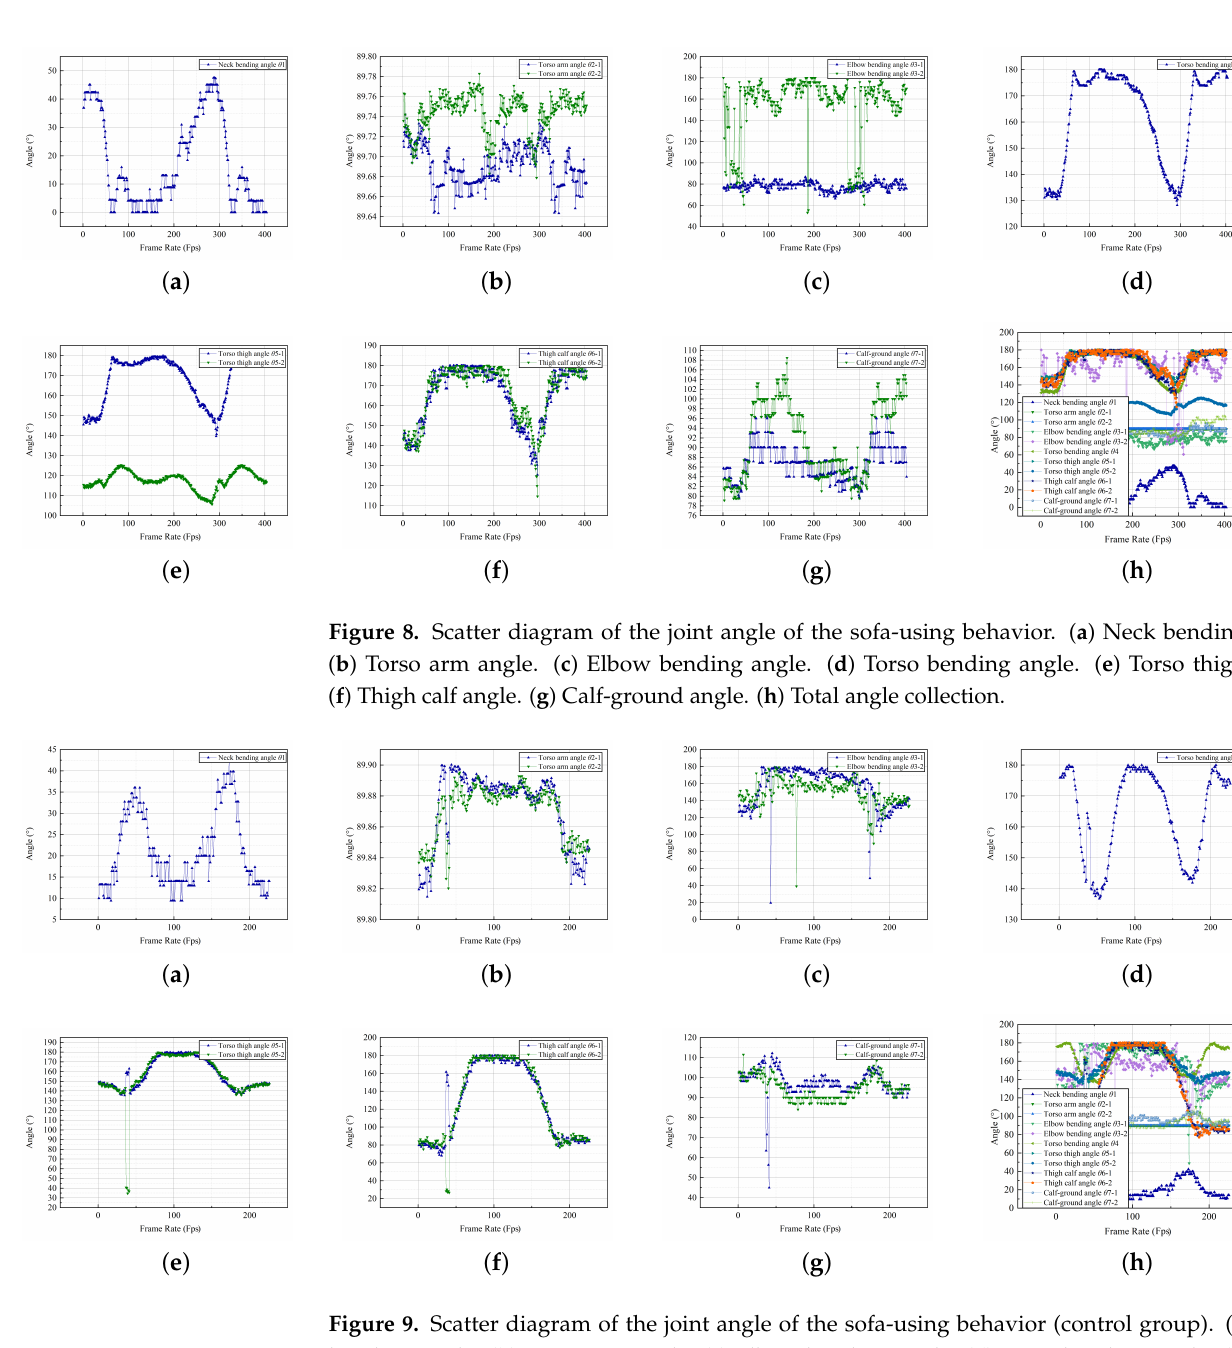
Figure 9. Scatter diagram of the joint angle of the sofa-using behavior (control group). ( a ) Neck bending angle. ( b ) Torso arm angle. ( c ) Elbow bending angle. ( d ) Torso bending angle. ( e ) Torso thigh angle. ( f ) Thigh calf angle. ( g ) Calf-ground angle. ( h ) Total angle